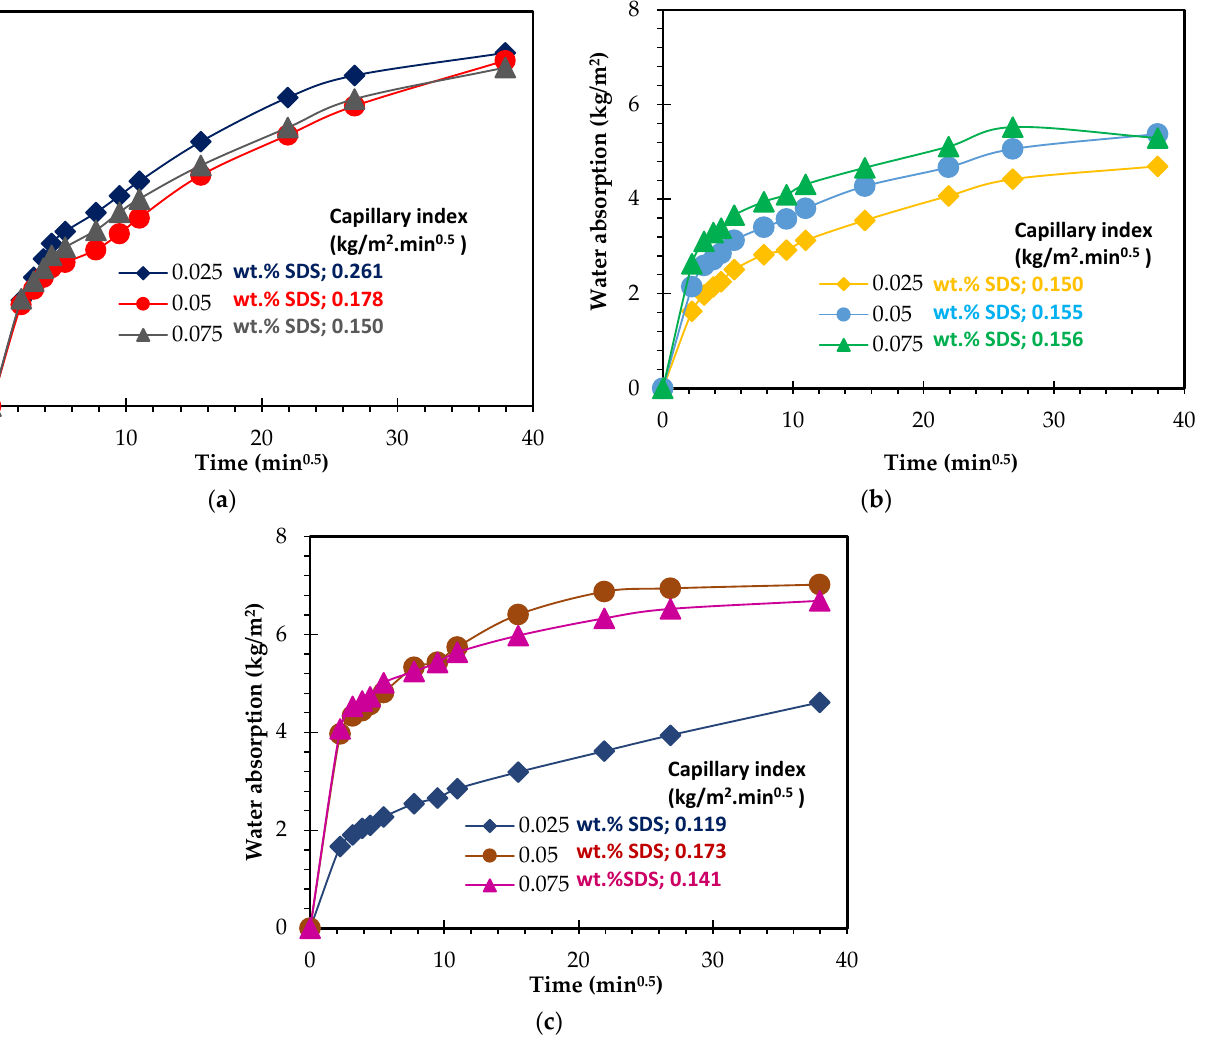
Figure 8. Capillary water absorption and index of GFs prepared with different content (0.025, 0.05, and 0.075 wt.%) of SDS and ( a ) 0.05 wt.% Al, ( b ) 0.075 wt.% Al, and ( c ) 0.1 wt.% Al.